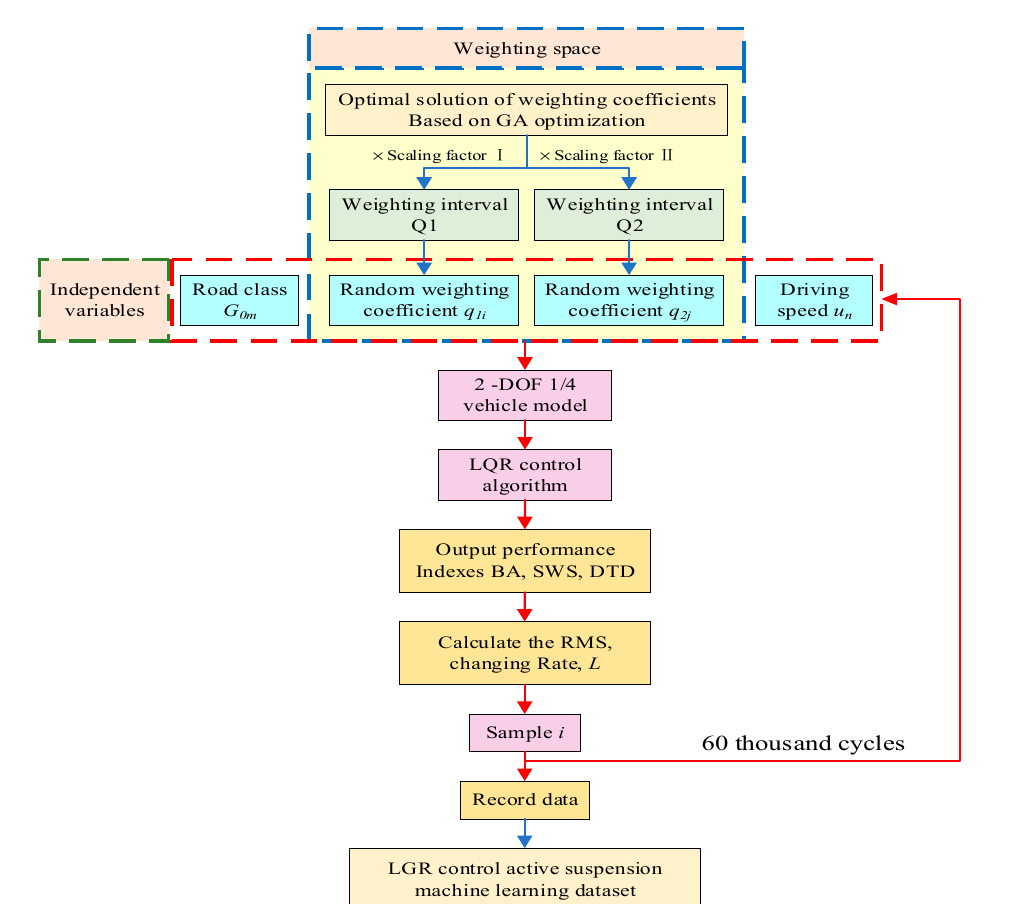
Figure 7. Process of constructing the machine learning dataset of LQR control active